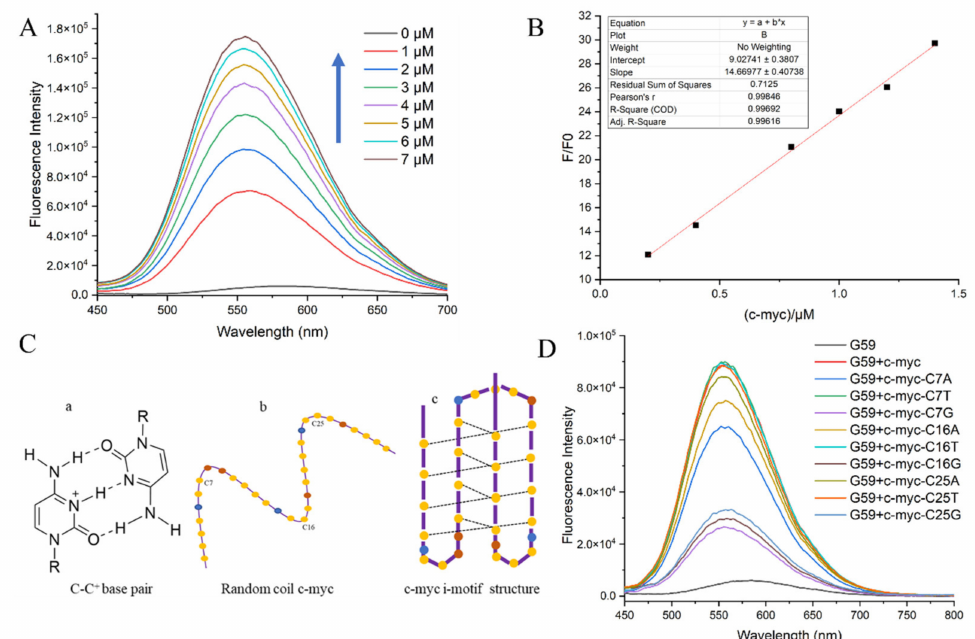
Figure 3. Fluorescent specificity of G59 upon addition of c-myc promoter i-motif in 1 × BPES buffer at pH 5.5 with λ ex of 407 nm. ( A ) Fluorescence titration of 1 µ M G59 through stepwise addition of c-myc promoter i-motif (arrows indicate 0–7 µ M). ( B ) A linear relationship was obtained for fluorescence intensity against increasing concentrations of c-myc promoter i-motif. ( C ) Schematic illustration of the i-motif structure: (a) cytosine-protonated cytosine base pair; (b) random coil c-myc promoter; (c) c-myc promoter i-motif structure, with yellow dots representing cytosine, blue dots representing adenine, and brown dots representing thymine. ( D ) Fluorescence spectra of c-myc promoter i-motif wild-type and